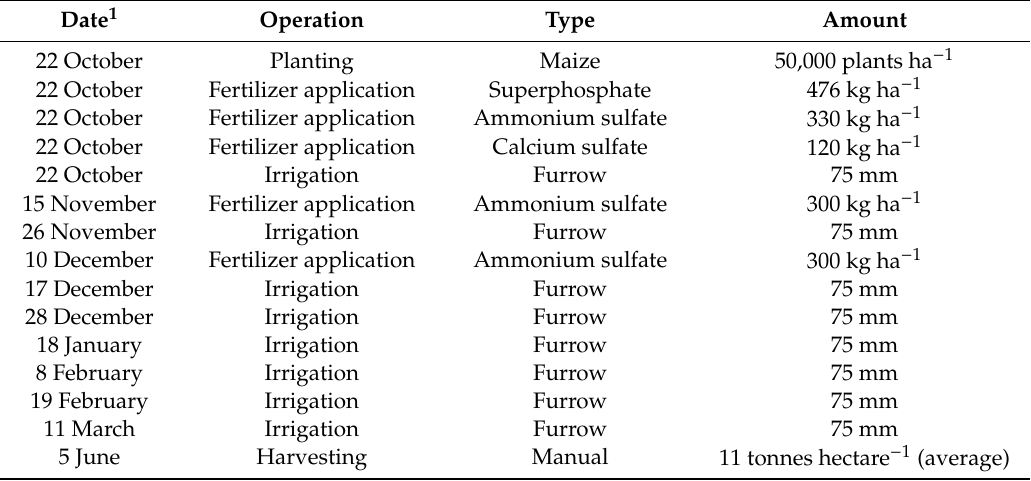
Table 2. Summary of management plan used for both field sites during the five years of the trial